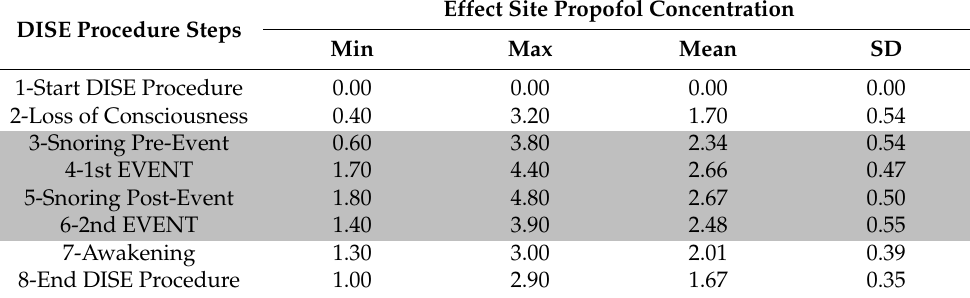
Table 3. Predicted effect site propofol concentration values recorded in each of the procedure steps on the entire test